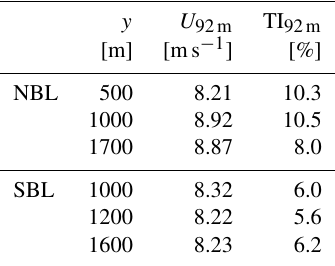
Table 5. Turbine positions along the y axis (keeping the same x po- sition), with the y direction spanning from 0 to 2595m for the NBL and from 0 to 2304m for the SBL, in the model domain of the main run; additionally, the local wind speed U 92m and turbulence inten- sity TI 92m at hub height at these y coordinates, taken 2.5 D in front of the turbine averaged over the last 10min of a 650s simulation. y U